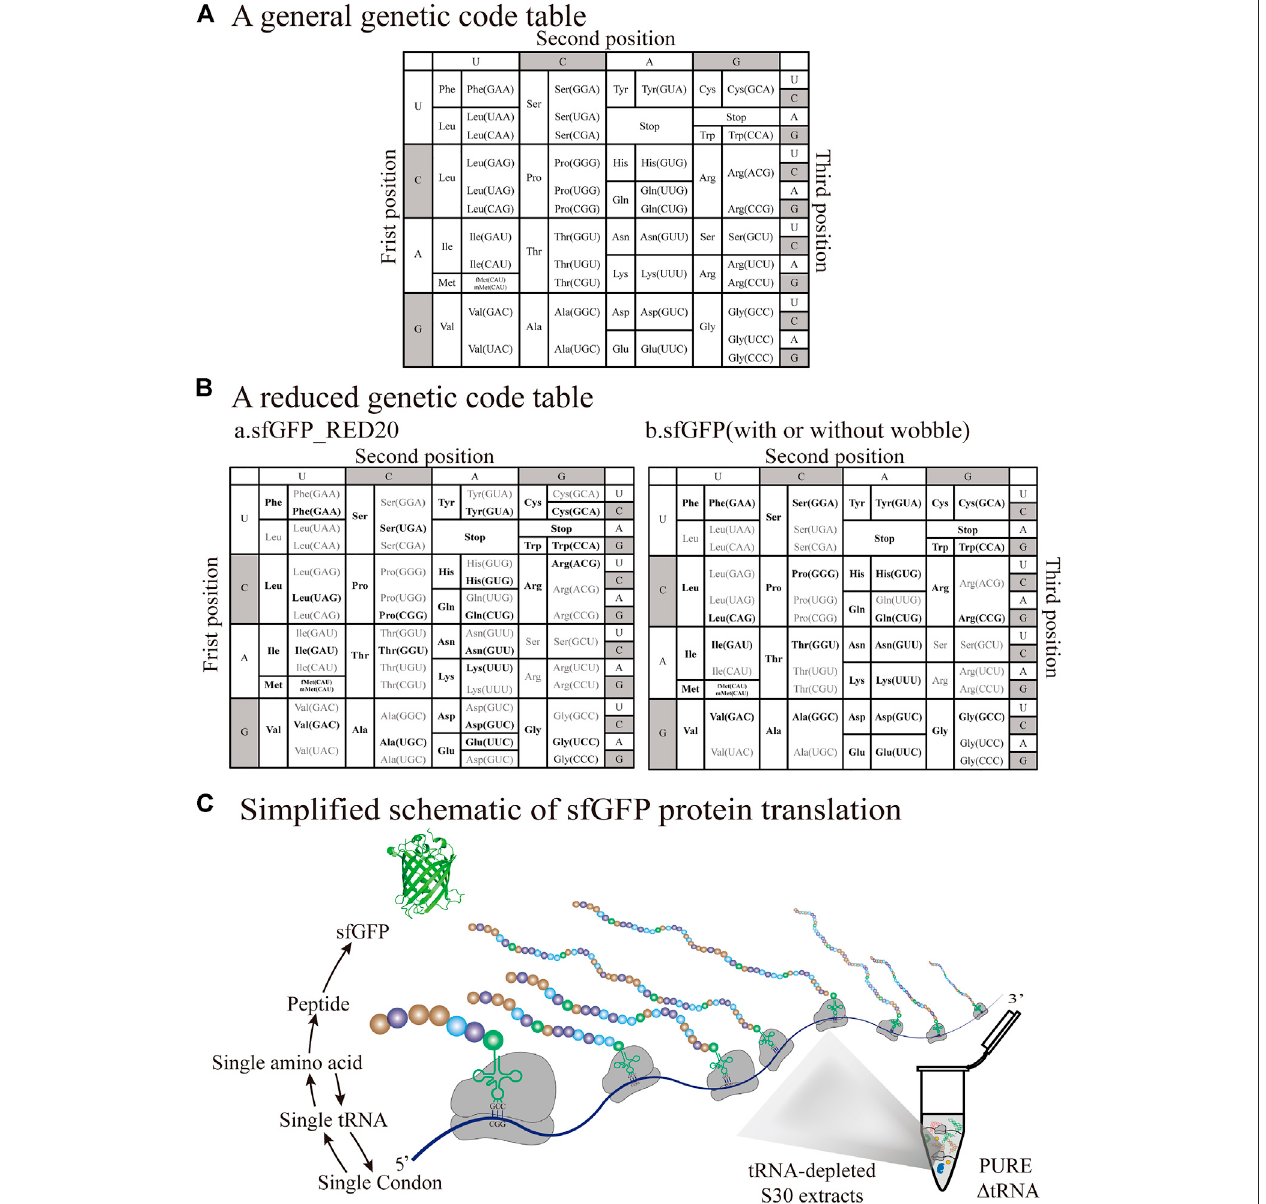
FIGURE6| SelectionofdifferenttRNAsets forthedecoding ofsfGFPtemplates withreduced-codons (A) Thenativegeneticcodetable of E.coli (B) Tworeduced geneticcodetables fortheproduction ofdifferentversions ofsfGFP(sfGFP_RED20and sfGFP;withorwithoutwobble, respectively, Unusedcodons arerepresentedin gray, while frequently used codons are represented in black (C) Simpli fi ed schematic of sfGFP protein translation based on the tRNA-depleted S30 extract and PURE Δ tRNA system. This sfGFP mRNA clearly shows the one-to-one correspondence in the codon-tRNA-amino acid relationship.